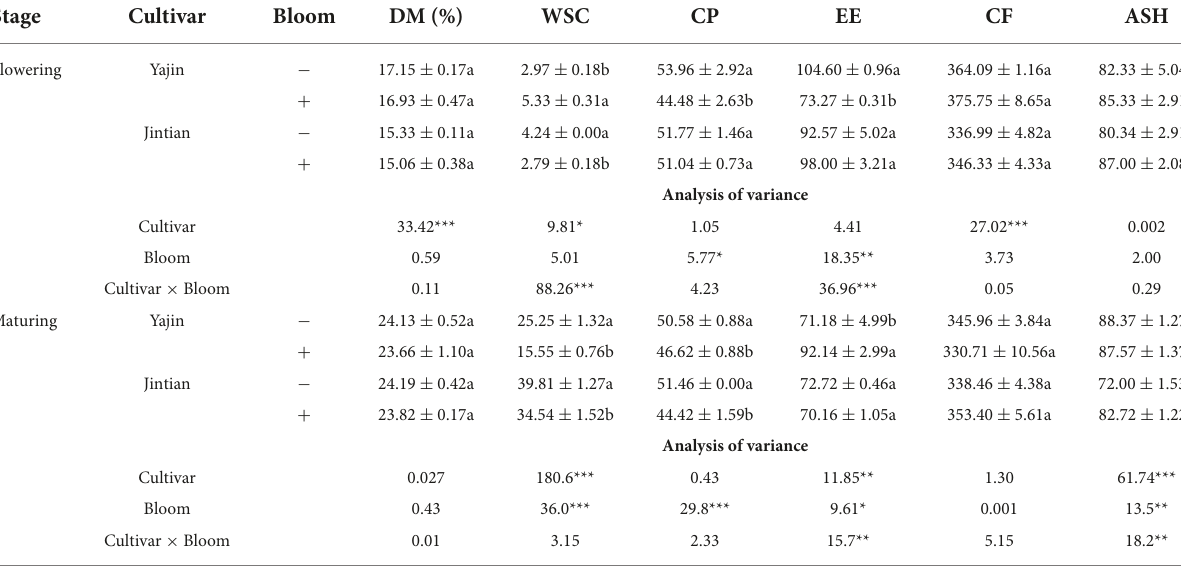
TABLE 3 The chemical composition (g kg − 1 DM) of sweet sorghum silage at flowering and maturing stages.